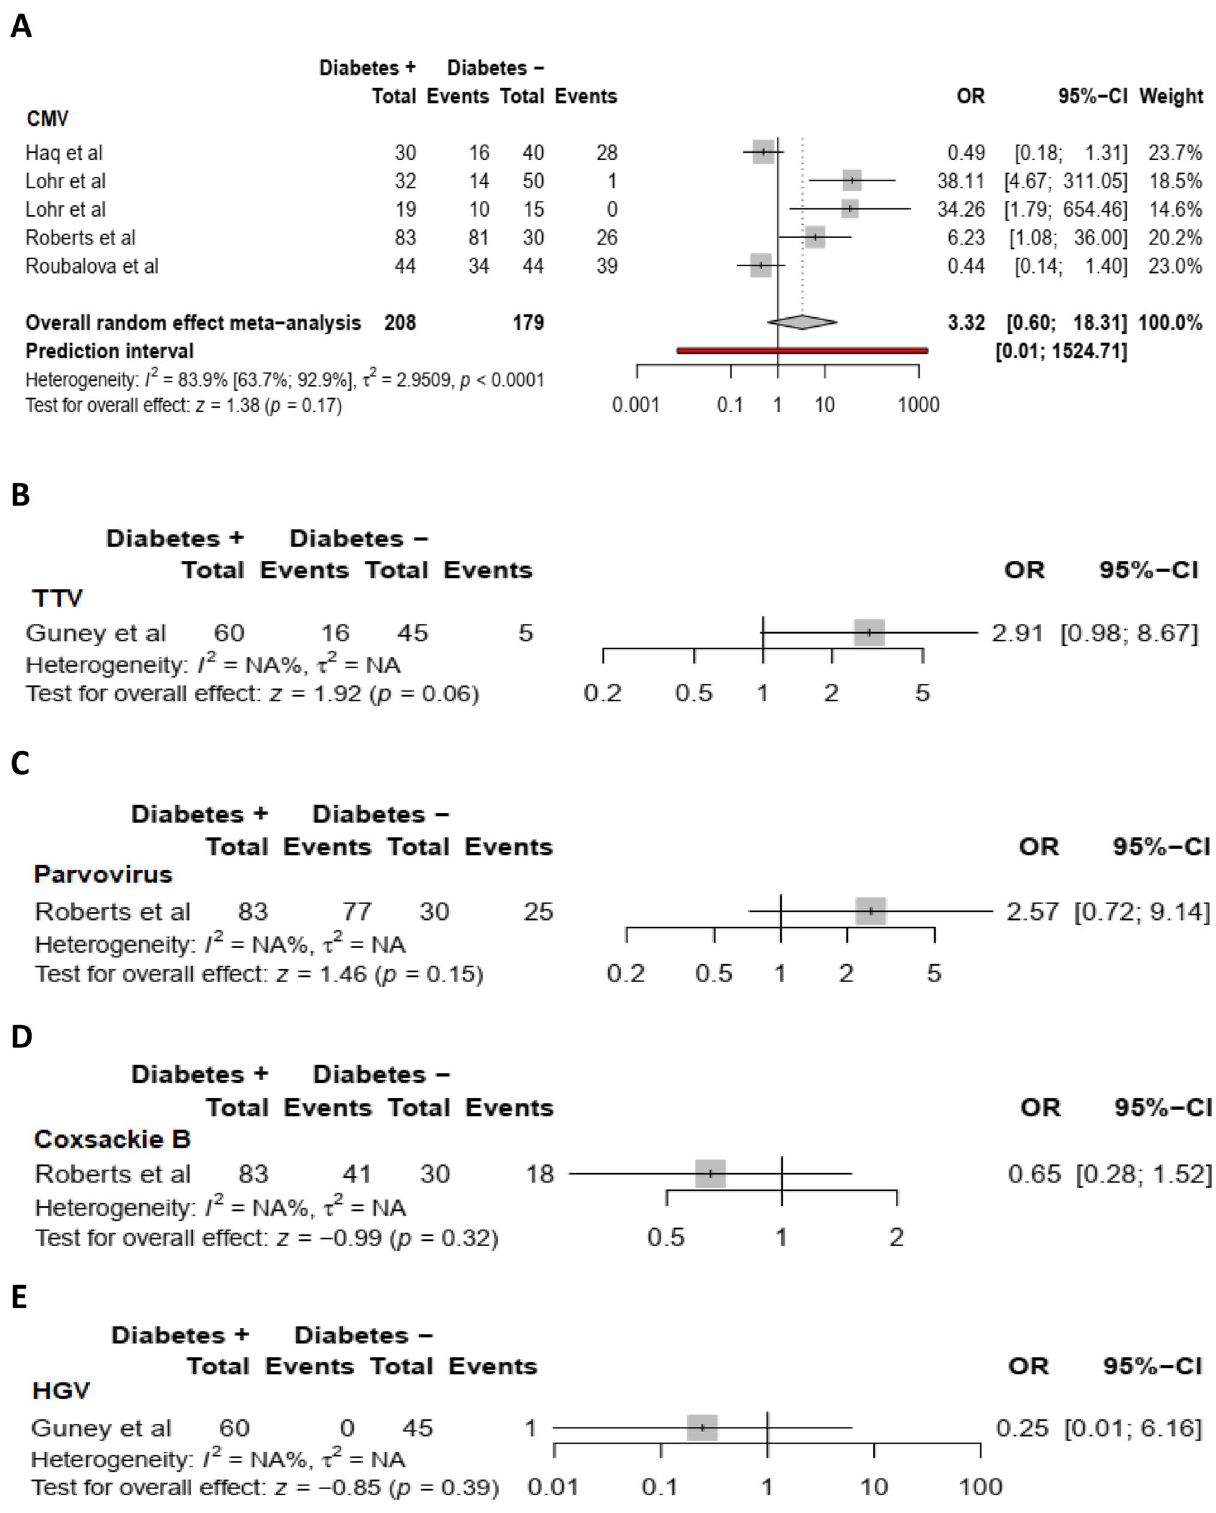
Figure 4. Meta-analysis of the association between CMV ( A ), TTV ( B ), Parvovirus B19 ( C ), Coxsackie B virus ( D ), HGV ( E ) and non-autoimmune diabetes